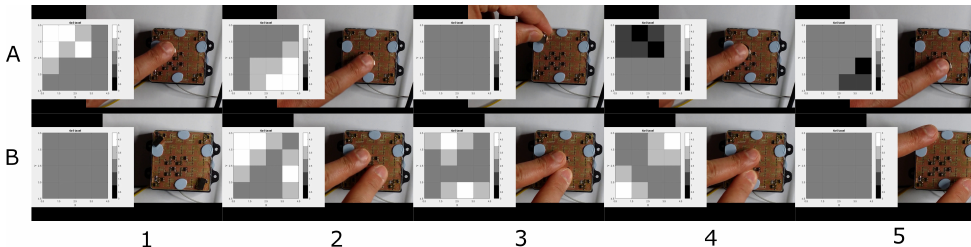
Figure 7. ( A ) Sequence of diagonal top left-bottom right then, change in magnet polarity and same diagonal path. ( B ) Sequence of the movement of two